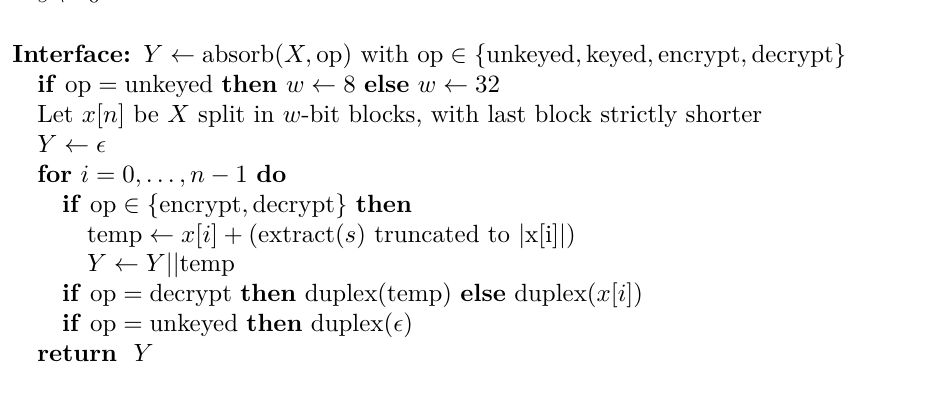
Algorithm 1 Subterranean duplex